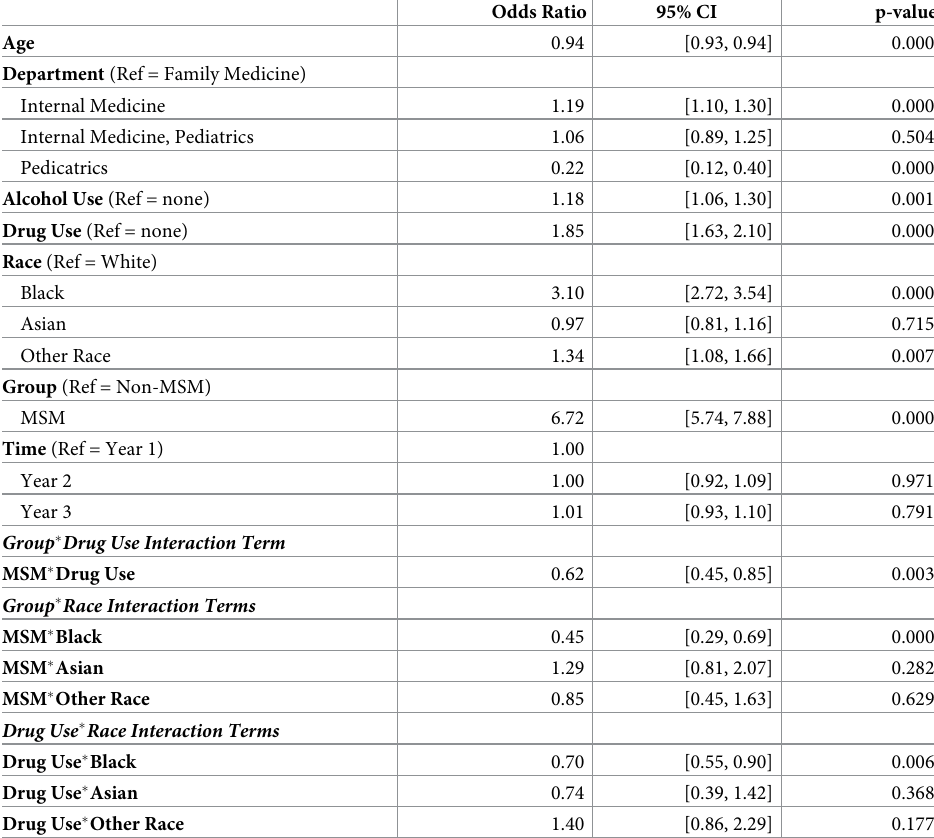
Table 3. GEE model results on HIV test